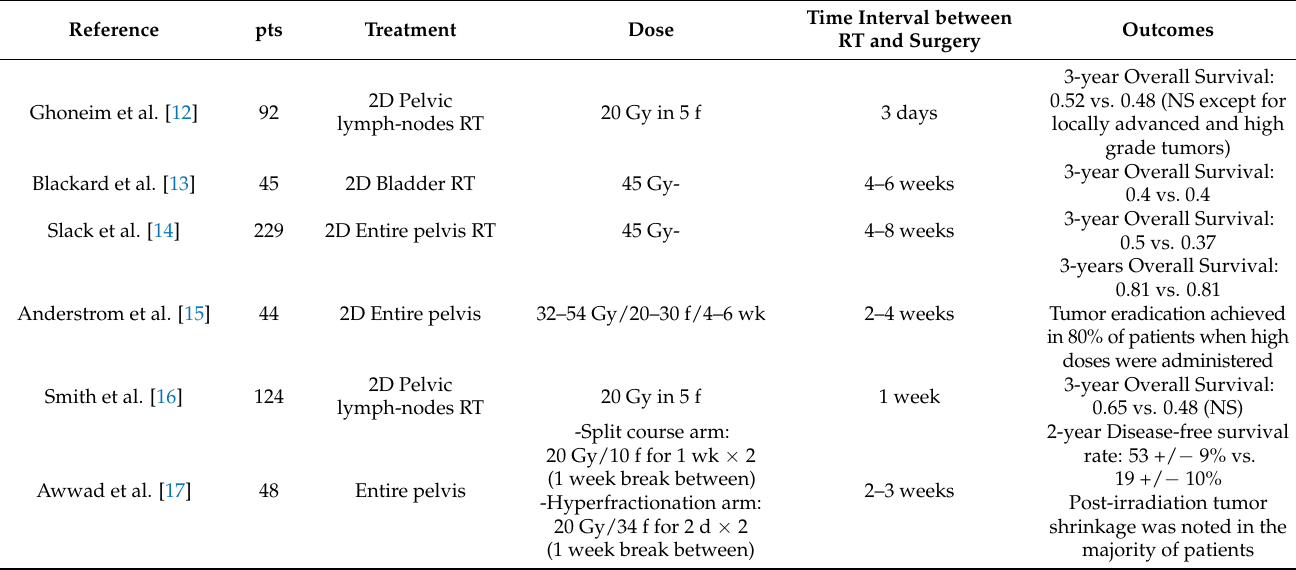
Table 1. Summary of pre-operative radiotherapy vs. control studies in bladder cancer patients. RT: radiotherapy; f: fractions; pts: